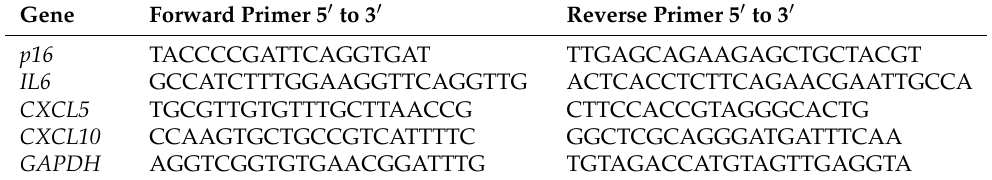
Table 2. Primers for specific mouse